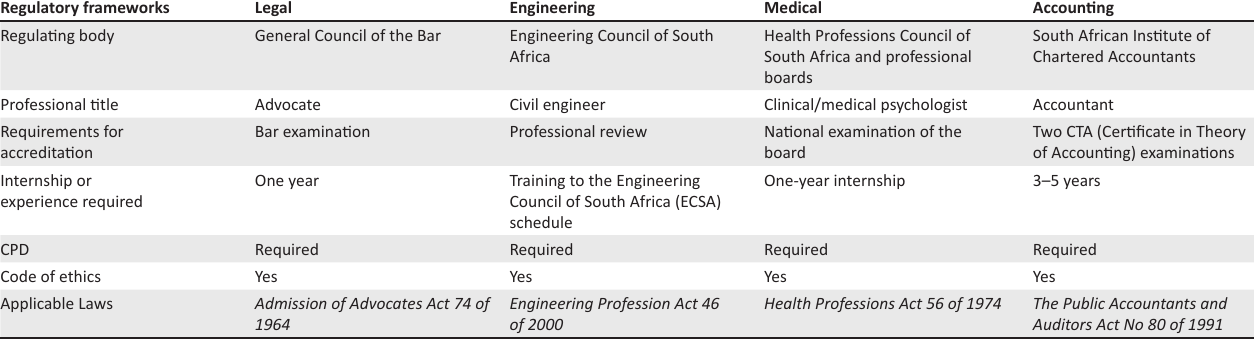
TABLE 1: Regulatory frameworks of the legal, engineering, medical and accounting professions in South Africa. Regulatory